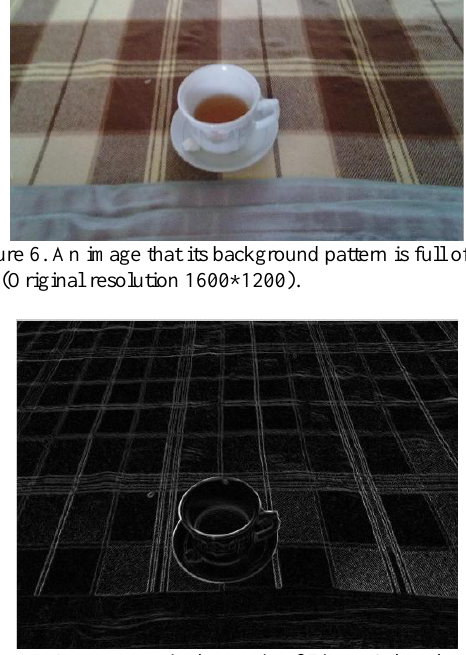
Figure 7. Canny magnitude matrix of Figure 6 that shows high values for background.